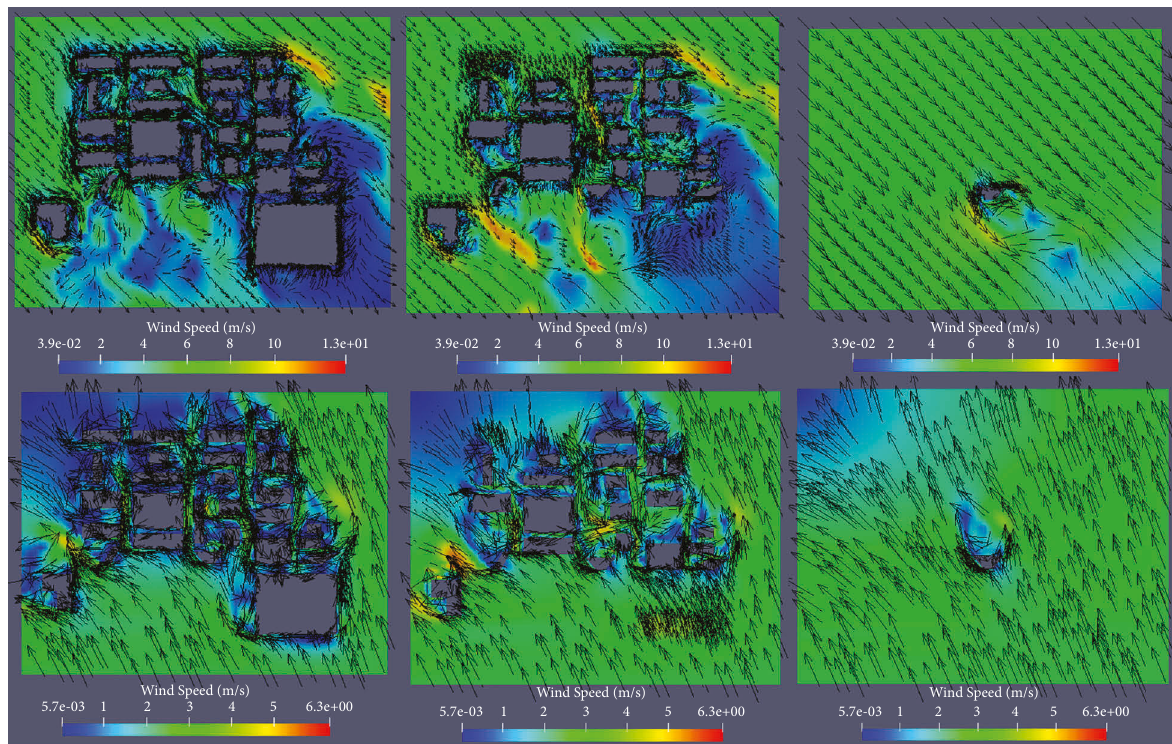
Figure 6: Top panels: slices of the simulated wind speed over Downtown OKC on January 1 at 1 am using S5 at a height of 4 m (top left panel), 35m (top middle panel), and 200m (top right panel). Bottom panels: slices of the simulated wind speed over Downtown OKC on January 2 at 6 pm using S5 at a height of 4 m (bottom left panel), 35m (bottom middle panel), and 200m (bottom right panel). The visualization is executed by ParaView Software [41]. Black arrows show wind direction vectors. Table 8: Wind speed statistics over KCB103 and KCB104.